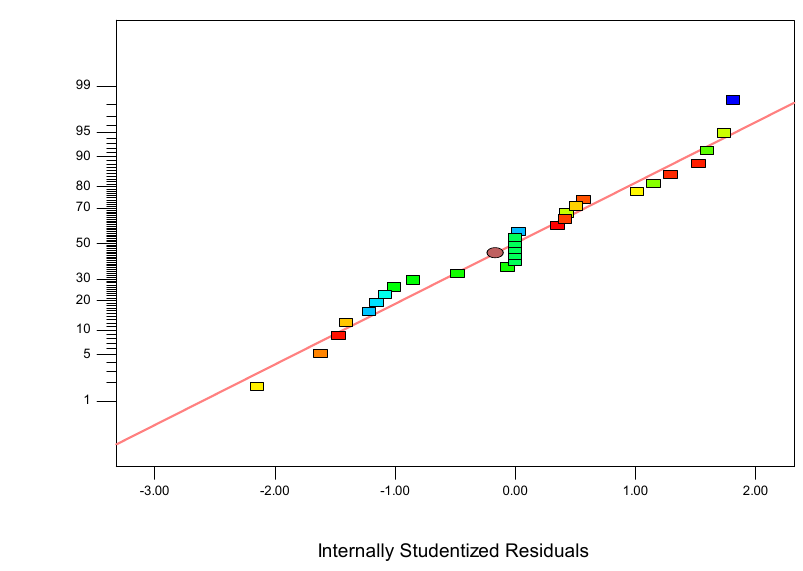
Figure 8. Normal plot of studentized residuals versus normal percent